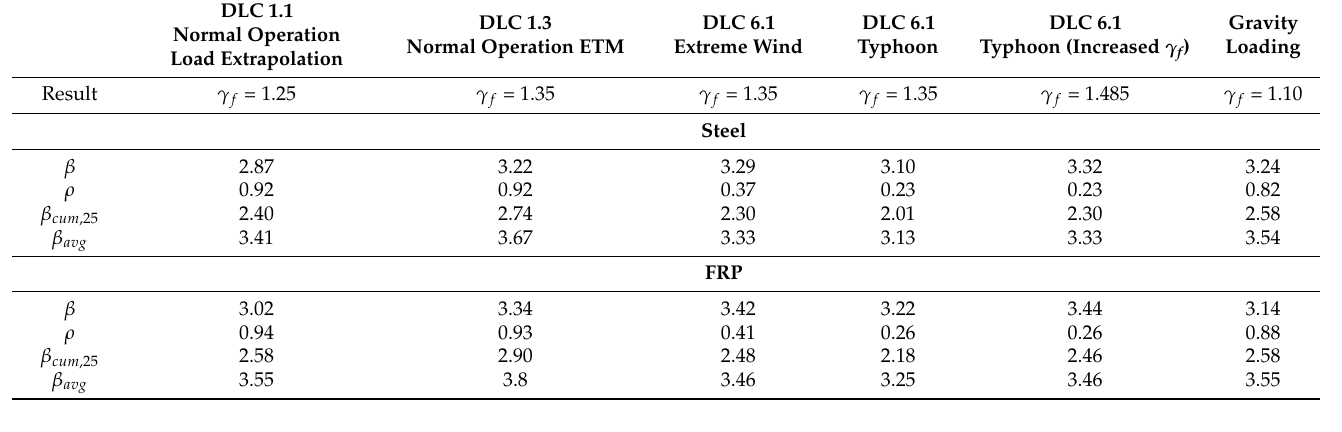
Table 3. Annual reliability indices, correlation coefficients between limit states for different years, 25-year reliability indices, and average reliability index for generic extreme load cases in IEC61400- 1 when using the stochastic model in Tables 1 and 2. The numbers in italic are the applied load safety factors.